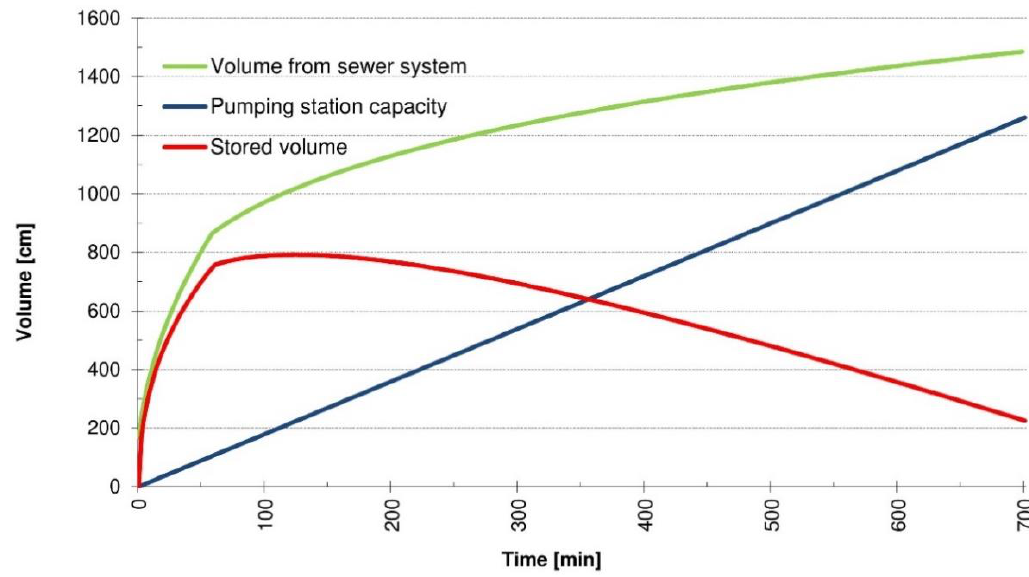
Figure 4. Graph showing the analysis of the detention tank volume with a return period of 10 years. By this approach, the detention volume to be stored in the tank with a return period of 10 years and 50 years is about 800 m 3 and 1300 m 3 , respectively.